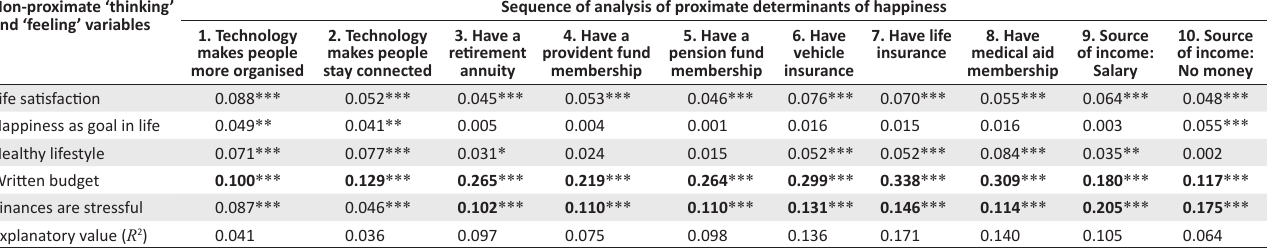
Sequence of analysis of proximate determinants of happiness